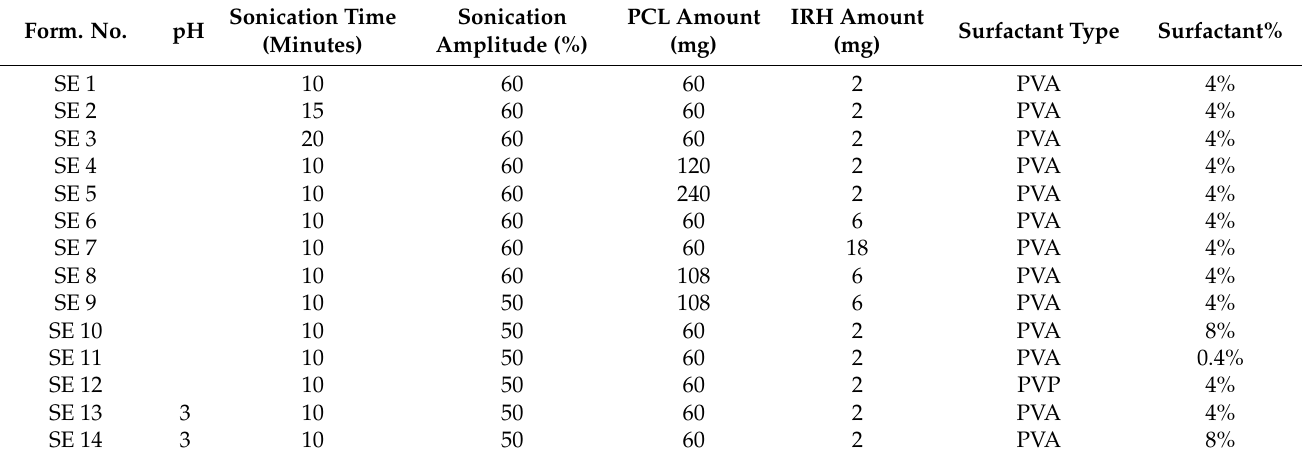
Table 1. Single emulsion process and formulation parameters using PVA (MW 13K) and PVP (MW 40K) surfactants. Form.